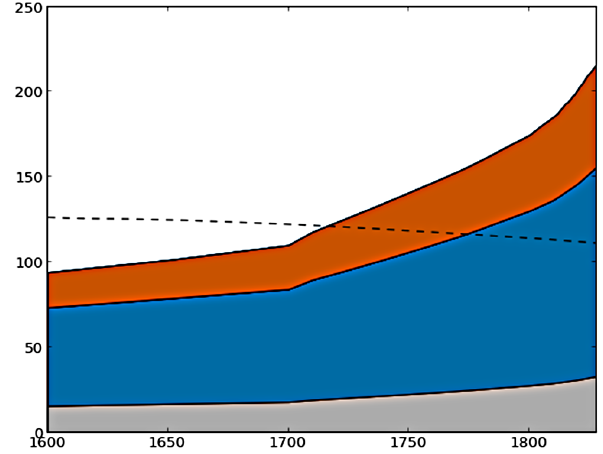
Figure 4. Total estimated wood demand (stacked surfaces) and wood supply (dashed line) in TgC between 1600 and 1829. The wood demand distinguishes between fuelwood for households (grey), fuelwood for salt production (not visible), fuelwood for in- dustrial processes (blue) and timber used for construction (brown). Expansion factors and assumptions of this reconstruction are de- tailed in Table